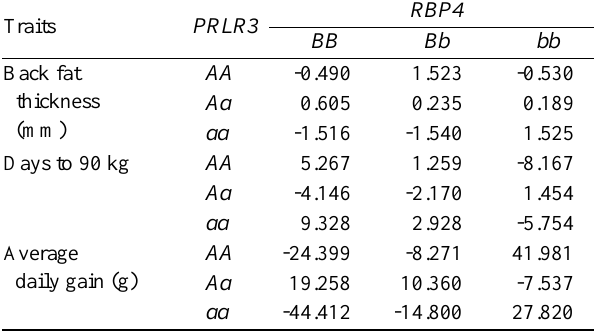
Table 7. Epistatic effects of PRLR3 / RBP4 genes 1